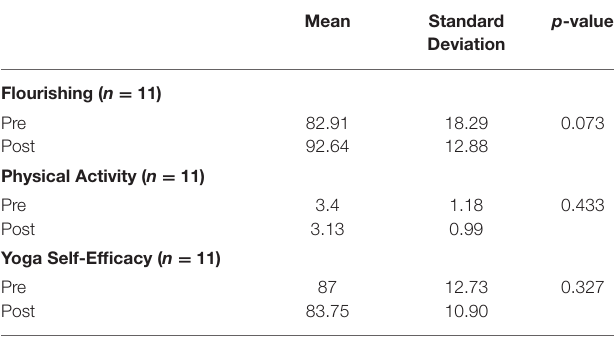
TABLE 2 | Phase III (MUSCLE 9-week) program